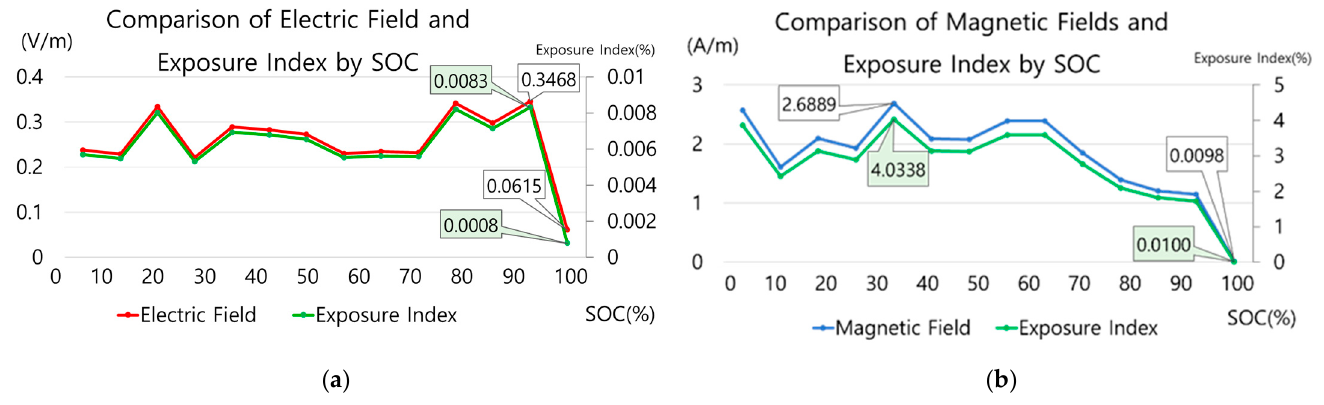
Figure 7 . Electromagnetic field characteristics about fast stand-type C main body SoC change ( a ) Comparison of electric field measurement and exposure index ( b ) Magnetic field measurement and exposure index comparison.